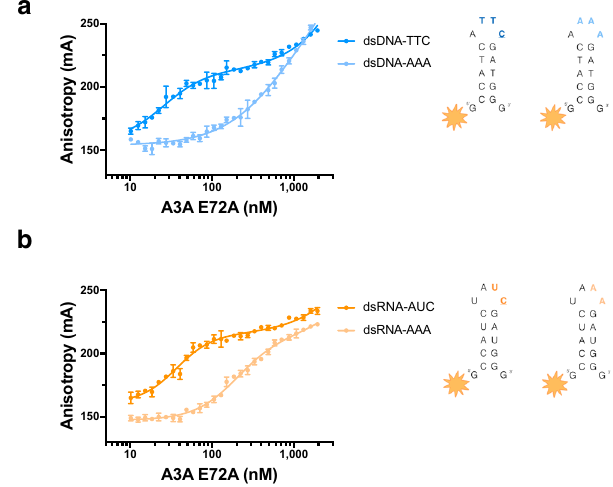
Figure 6. A3A specificity for substrate in loop region of stem-loop (hairpin) nucleic acids. Fluorescence anisotropy of TAMRA-labeled hairpin DNA and RNA binding to A3A(E72A). ( a ) Binding of A3A to a DNA version of the hairpin SDHB RNA containing TTC (dark blue) and AAA (light blue) in the loop region. ( b ) Binding of A3A to hairpin SDHB RNA (dark orange) and the same RNA sequence replacing the UC with AA in the loop region of the hairpin (light